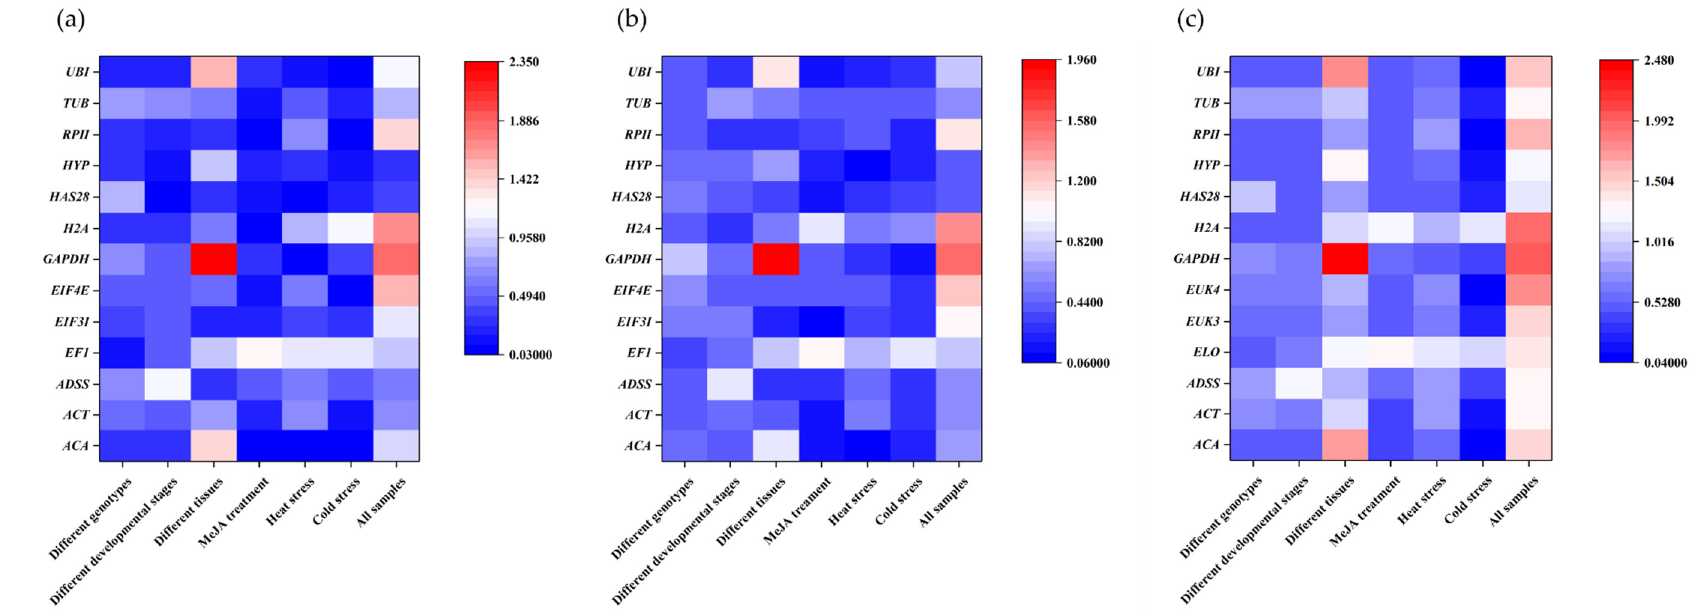
Figure 4. The expression stabilities of G. biloba reference genes according to three software methods: ( a ) the NormFinder program, ( b ) the BestKeeper program, and ( c ) the Δ Ct method. The spectrum from red to blue indicates low- to high-stability.